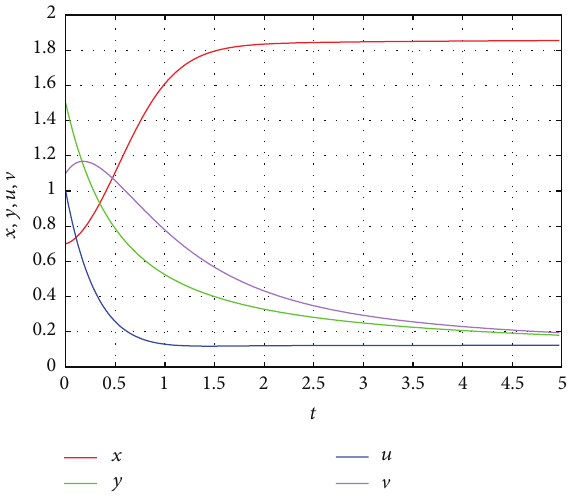
Figure 1: Dynamic behavior of system (48) with the initial (𝑥(0),𝑦(0),𝑢(0), V (0)) 𝑇 = (0.7, 1.5, 1.0, 1.1) 𝑇 , for 𝜏 = 0 , 𝑡 ∈ [0,5] . From the figure, we could easily see that the solution (𝑥(𝑡),𝑦(𝑡),𝑢(𝑡), V (𝑡)) 𝑇 is asymptotic to the unique almost periodic solution of the system